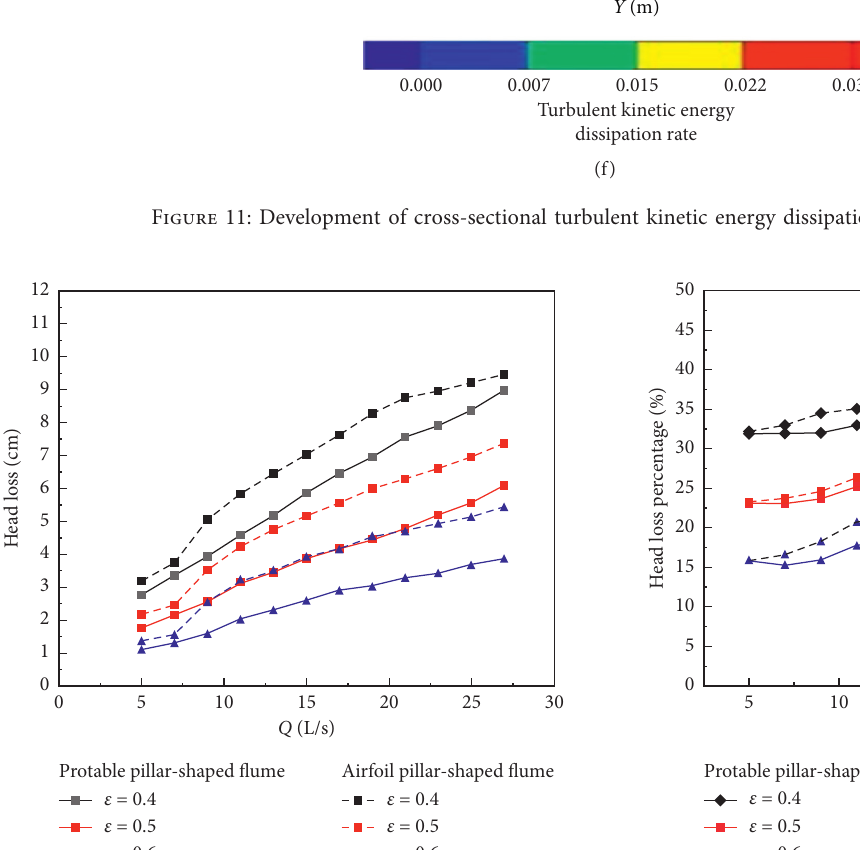
Protable pillar-shaped flume